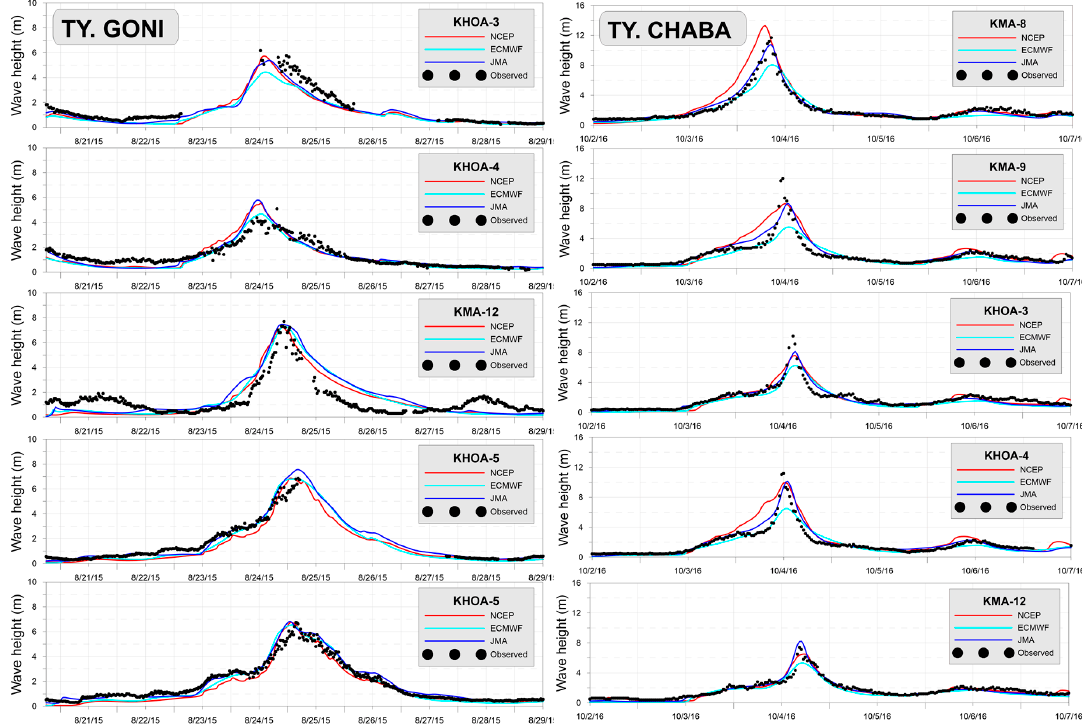
Figure 18. Measured and computed time series of significant wave heights among the three wind fields during Typhoons GONI (2015) and CHABA (2016).